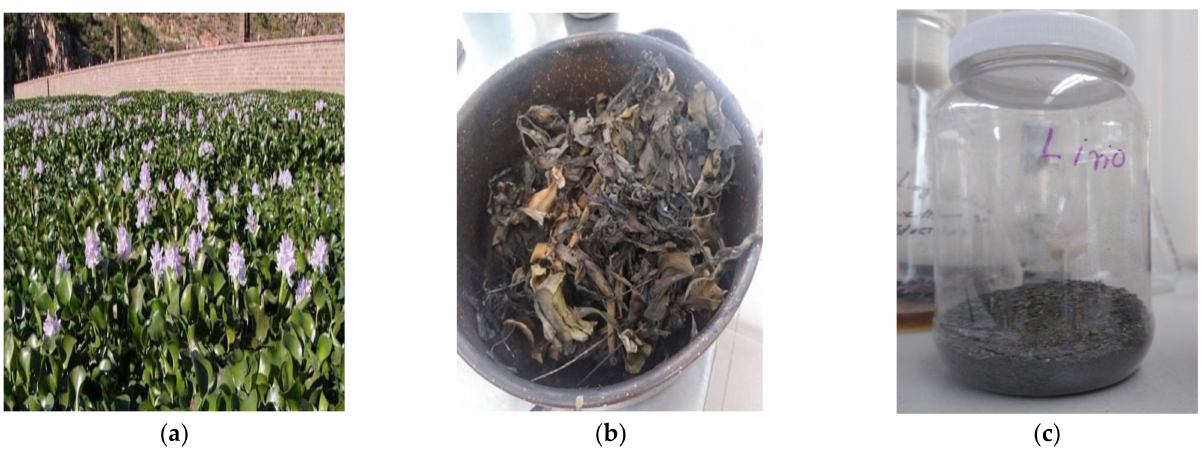
Figure 1. Natural biomass of water lily utilized: ( a ) water lily growth in San Jos é Dam. San Luis Potos í , S.L.P. M é xico ( b ) Water lily collected and washed ( c ) Stored and ground